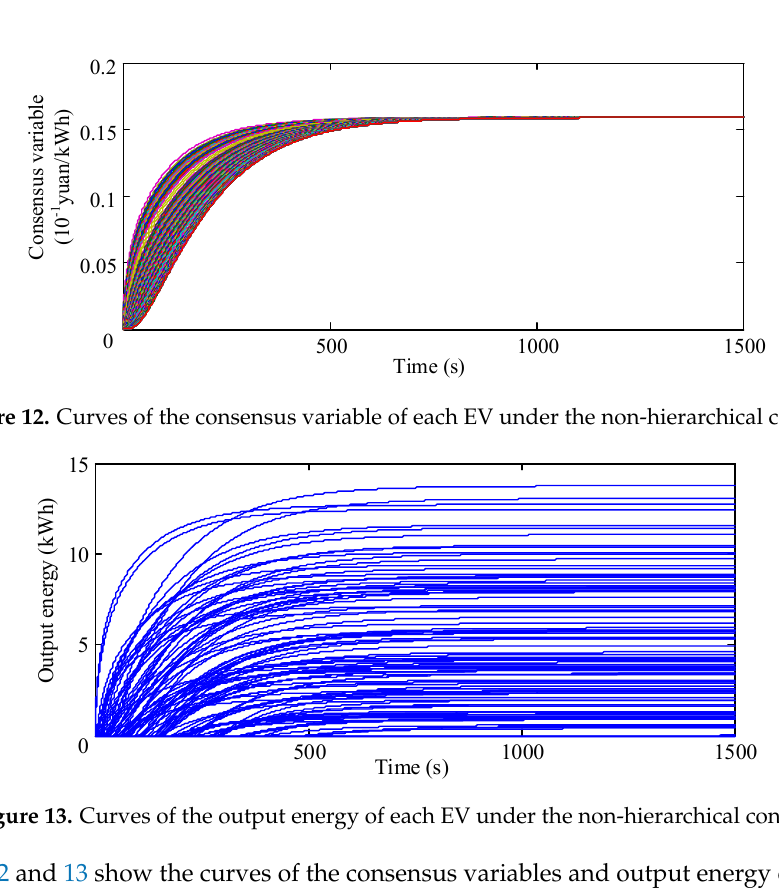
12 Figure 11. Response time under different communication capabilities. As shown in Figure 11, the system converged to the target value more quickly and responded more quickly to the scheduling command with the enhancement of the wireless signal communication capability. However, when the number of charging piles were more than eight, there was no significant change in the response time with increasing number of charging piles. In order to illustrate the superiority of the hierarchical control, the following examples adopted